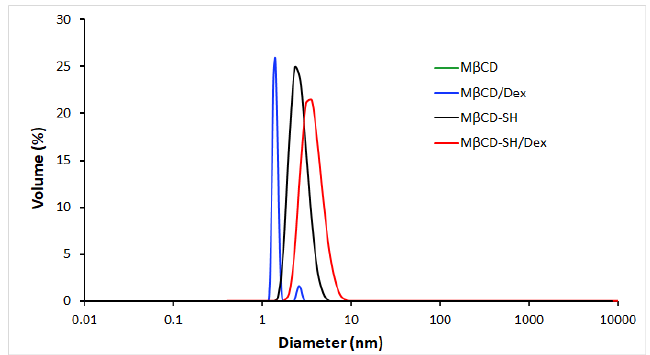
Figure 6. Particle size distribution in water of 0.3% cyclodextrin either plain (MβCD; MβCD -SH) and as inclusion complexes of Dex (MβCD/Dex; MβCD - SH/Dex). MβCD (green line) did not show any aggregate (no peak in the graph) ; MβCD/Dex (blue line) showed aggregates of 1.5 ± 0.13 nm; MβCD -SH (black line) showed aggregates of 2.5 ± 0.4 nm; MβCD -SH/Dex (red line) showed aggregates of 4.7 ± 1.2 nm.